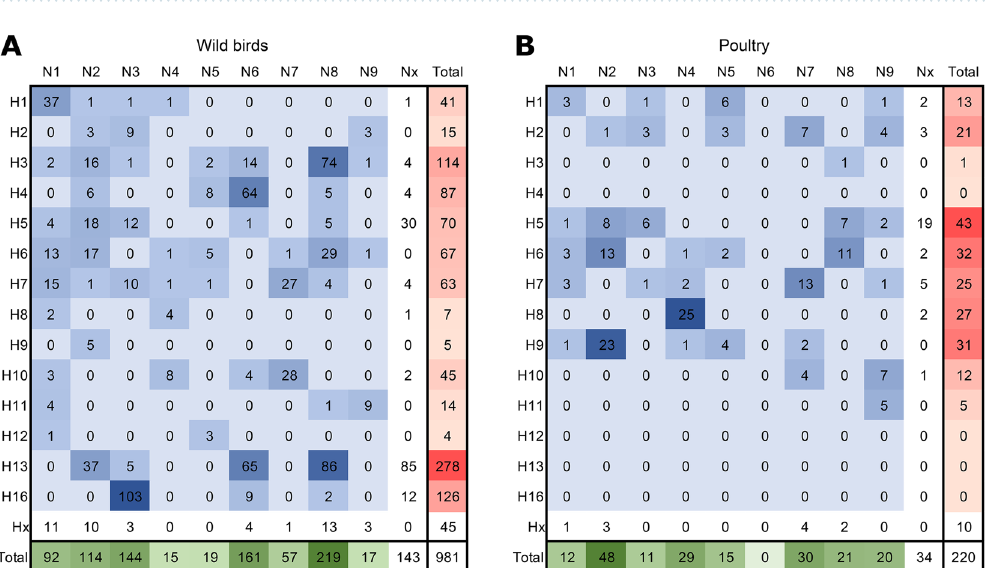
Figure 1. Collection and subtyping of wild bird and poultry samples. ( A ) Number of wild birds sampled and ( B ) number of subtyped cases of low pathogenic avian influenza (LPAI) virus detections in wild birds per wild bird species. ( C ) Number of poultry farms tested and ( D ) number of subtyped cases of LPAI virus detections in poultry farms per poultry type. All samples were collected as part of the national avian influenza (AI) surveillance program in the Netherlands, January 2006-September 2016. A case is considered subtyped if the hemagglutinin (HA) or neuraminidase (NA) subtype of the virus or the subtype-specificity of the influenza virus-specific antibodies is determined.